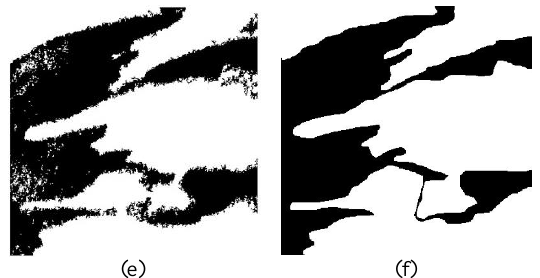
Figure 2. Segmentation of different methods: (a) Original image, (b)Otsu, (c) K-means, (d) GrowCut, (e) Proposed, (f) Ground truth